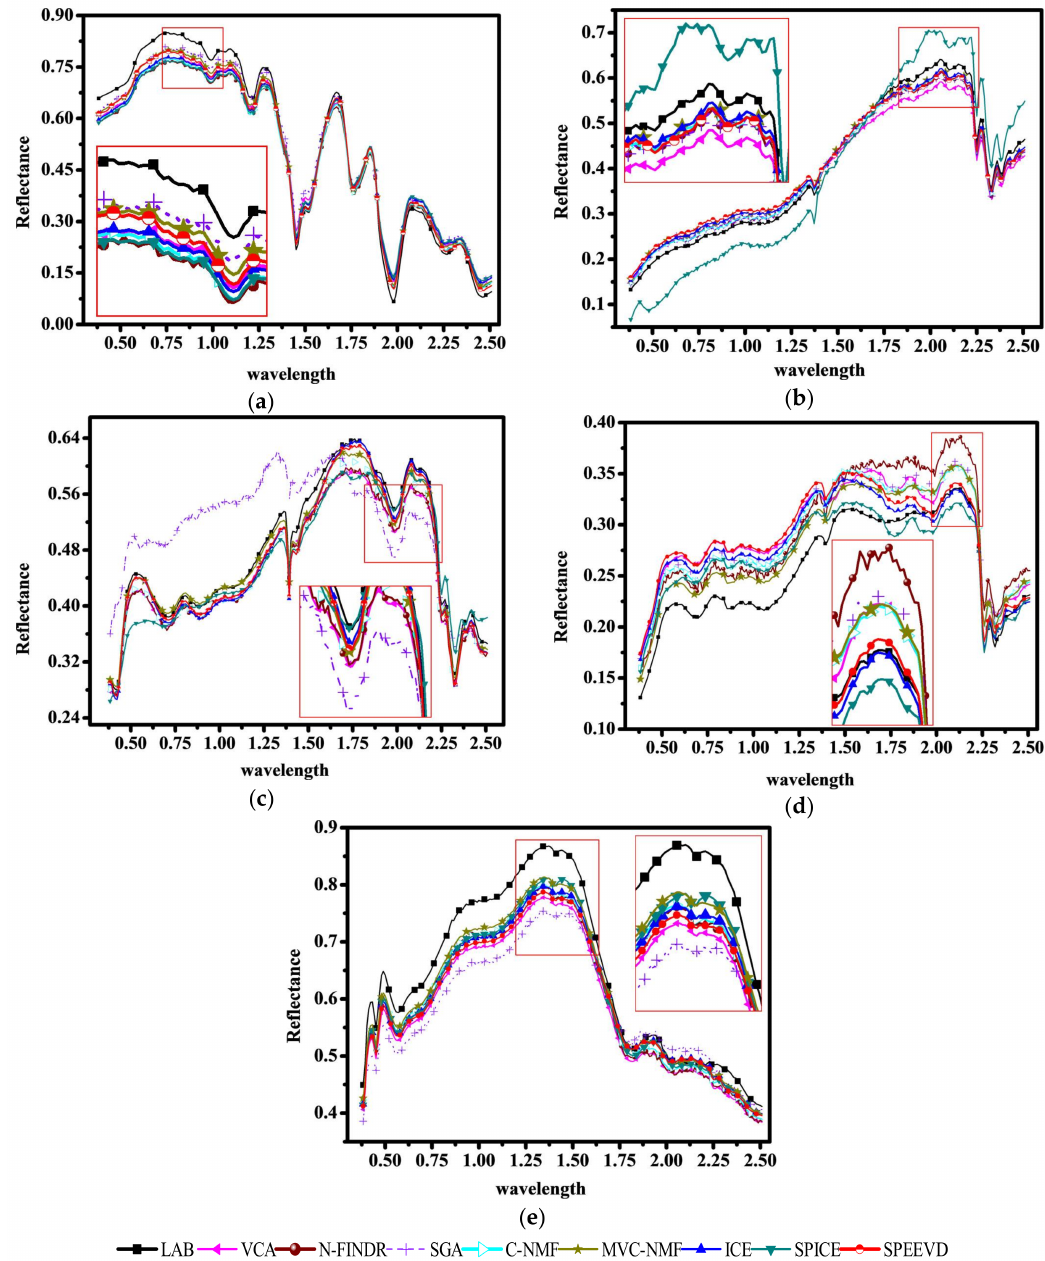
Figure 4. Spectra of five minerals with the different methods: ( a ) Carnallite, ( b ) Chlorite, ( c ) Clinochlore, ( d ) Clintonite, ( e )